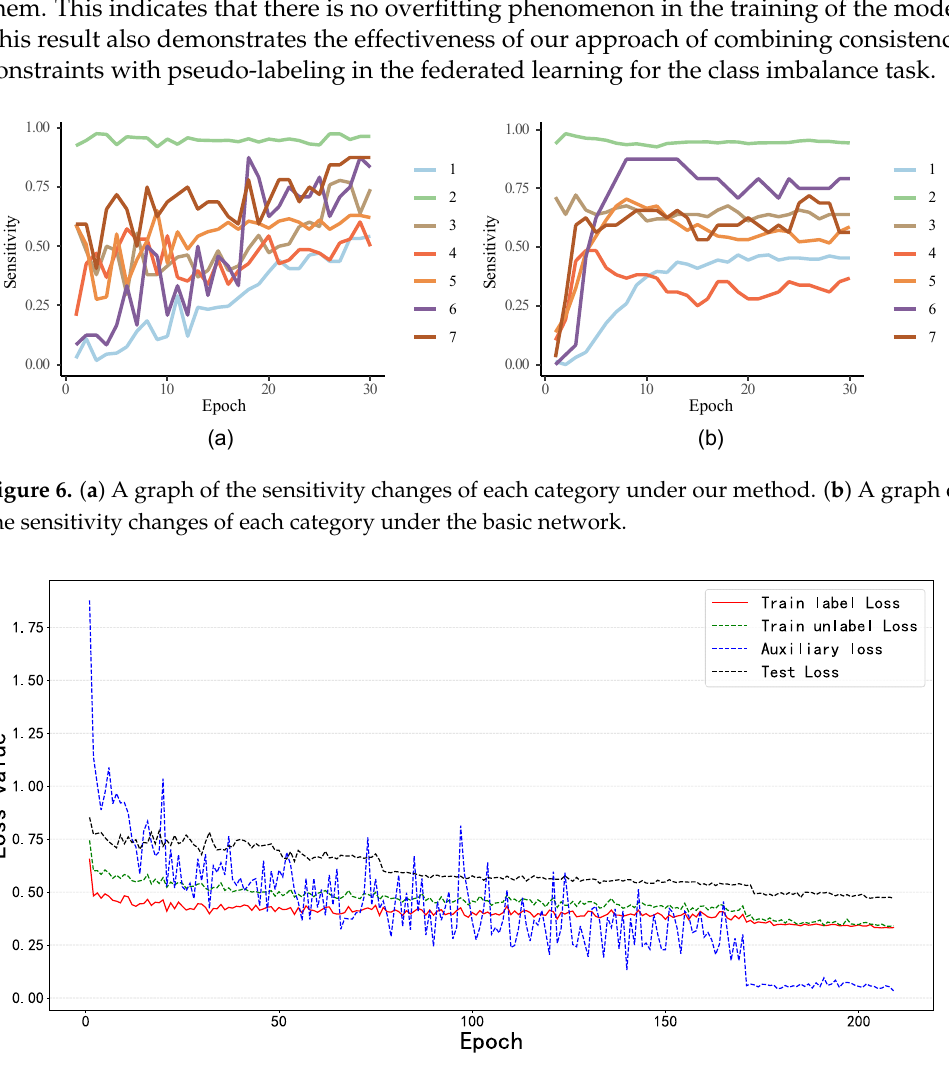
Table 3. Sensitivity of our method at different confidence thresholds.